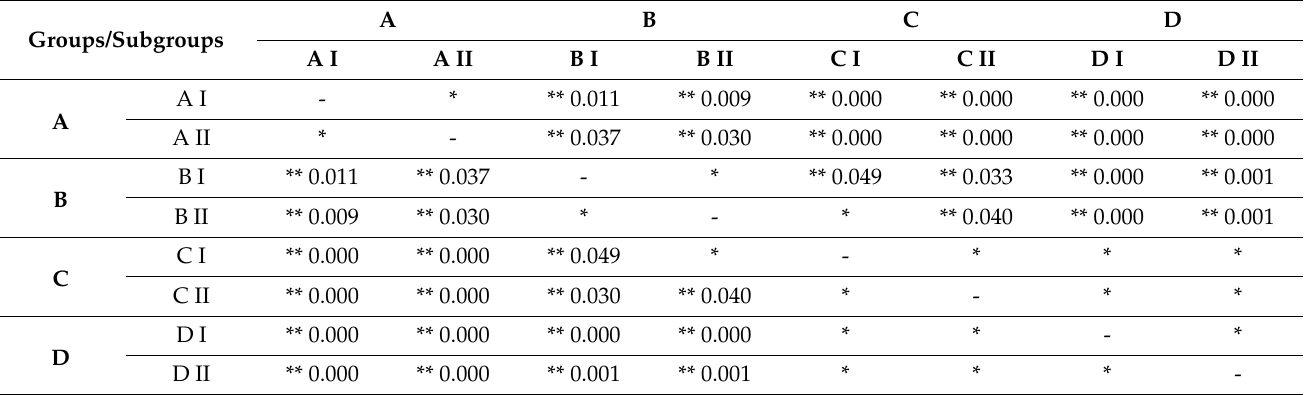
Table 2. Comparison of the data between the subgroups of each group in stage TB2.